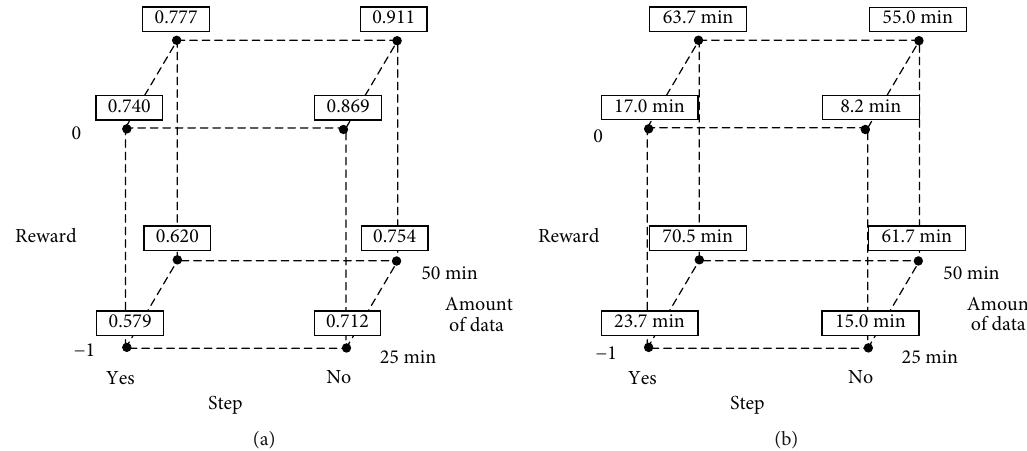
Figure 6: Cube plot of the factors in fl uences on the (a) average reward and (b) the time without vehicle velocity in the state vector.